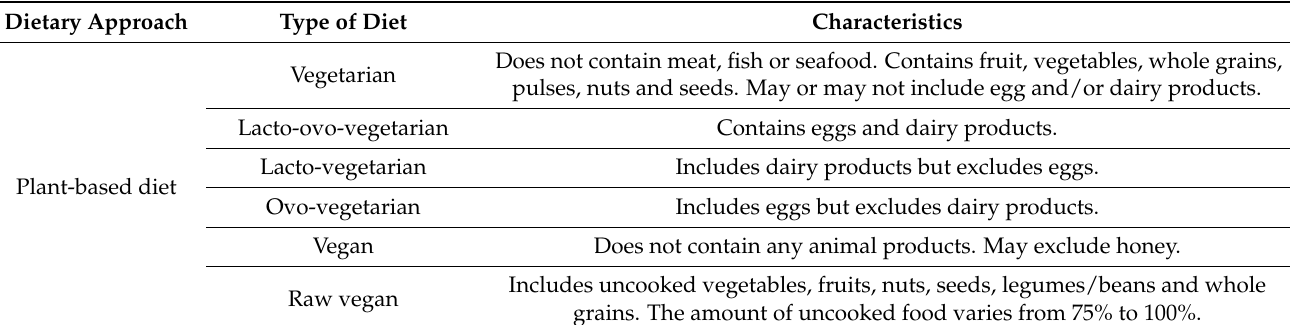
Table 1. Characteristic of plant-based diets. Dietary Approach Type of Diet Characteristics